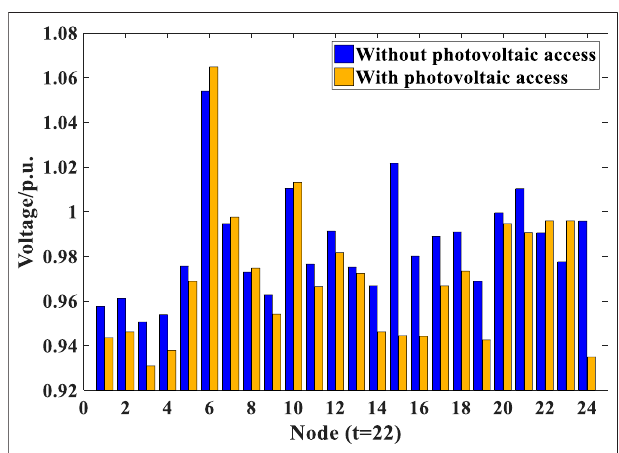
FIGURE 4 | Node voltage levels (p.u.) simulated without or with the PV access at off-peak time ( t (cid:1) 22).